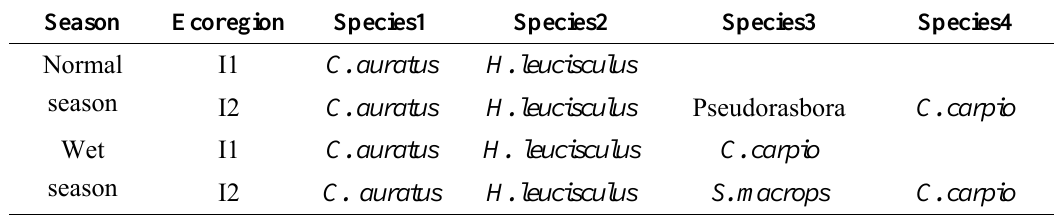
Table 4. Dominant species of fish in different aquatic ecoregions in the Taihu Lake